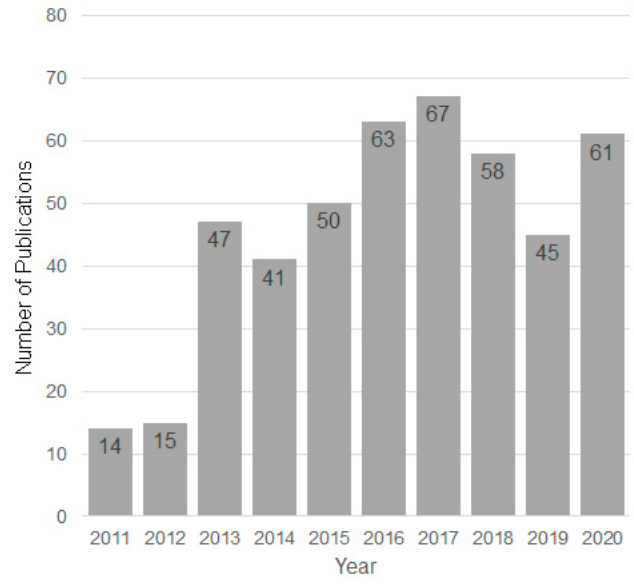
Figure 2. The number of publications per year referencing a limitation or challenge.